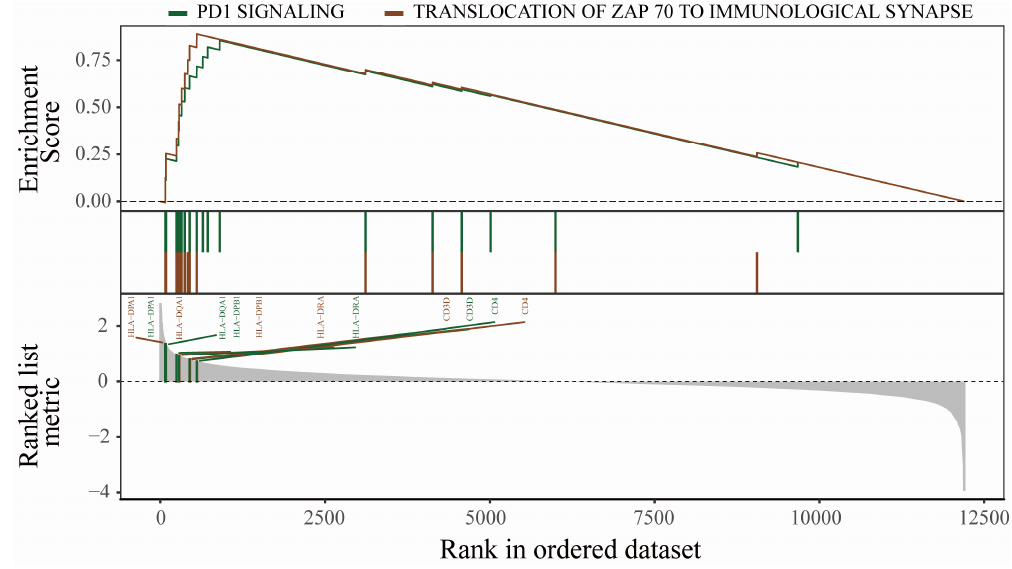
Figure 4. Gene set enrichment analysis. P -values were determined using the Kolmogorov–Smirnov test.